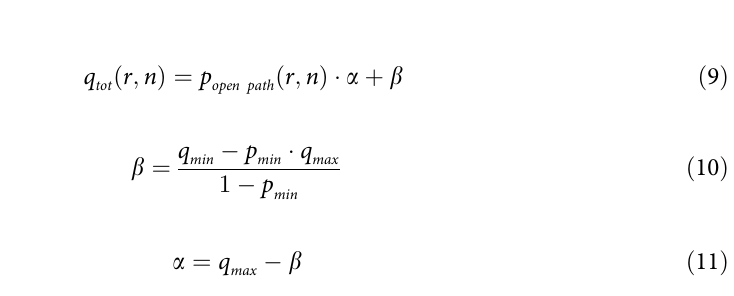
PLOS ONE | https://doi.org/10.1371/journal.pone.0208496 December19,